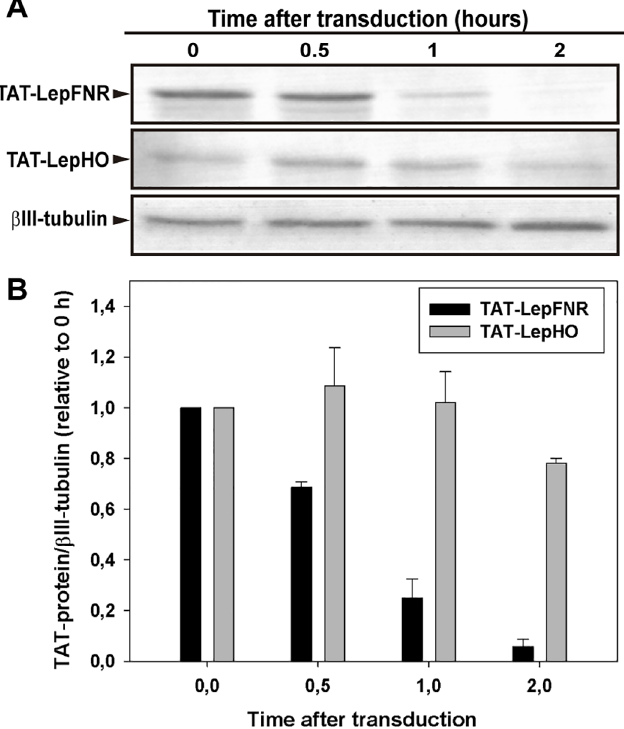
Fig 5. TAT-fusion protein stability inside the cell. (A) SH-SY5Y cells were incubatedwith 3 μ M TAT-LepFNR or TAT-LepHO in a serum free medium for 1 h. The medium was removed and cells were washedwith PBS buffer before a fresh medium was added.Cell extracts were preparedat different time intervals and examinedby Western blot analysis. Representative blots of 3 different experiments are shown. (B) Densitometric analysisof the transduced proteins. Protein levels were normalizedto that of β